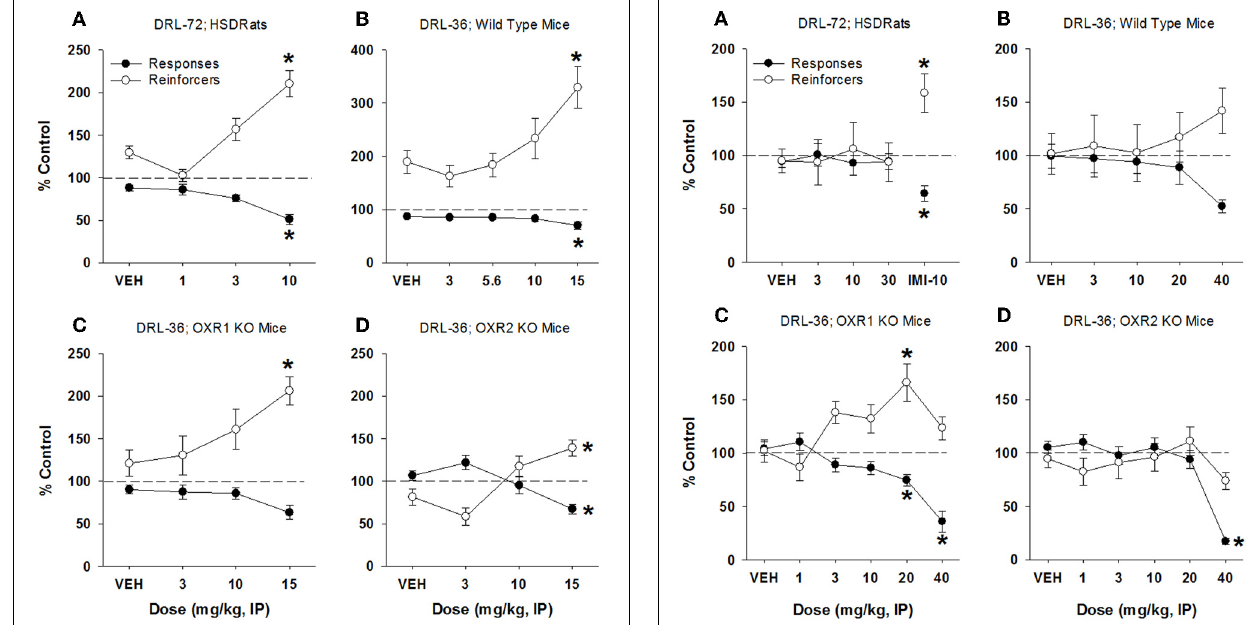
FIGURE 3 | Antidepressant-like effect of imipramine on DRL-72-s responding in rats and DRL-36-s responding in mice. Consistent with literature reports, imipramine produced a significant antidepressant-like effect in both rat DRL-72-s ( A ; n = 12) and mouse DRL-36-s models ( B ; n = 16), as demonstrated by a significant increase in reinforcers ( p < 0 . 001 and p < 0 . 01, respectively) and significant decrease in total responses emitted ( p < 0 . 01 and p < 0 . 001, respectively). Importantly, the antidepressant-like efficacy of imipramine was not altered in mice lacking OX1 or OX2 receptors ( C,D , respectively; n = 8). ∗ p < 0 . 05 vs. respective vehicle, Dunnett’s post-hoc analyses.